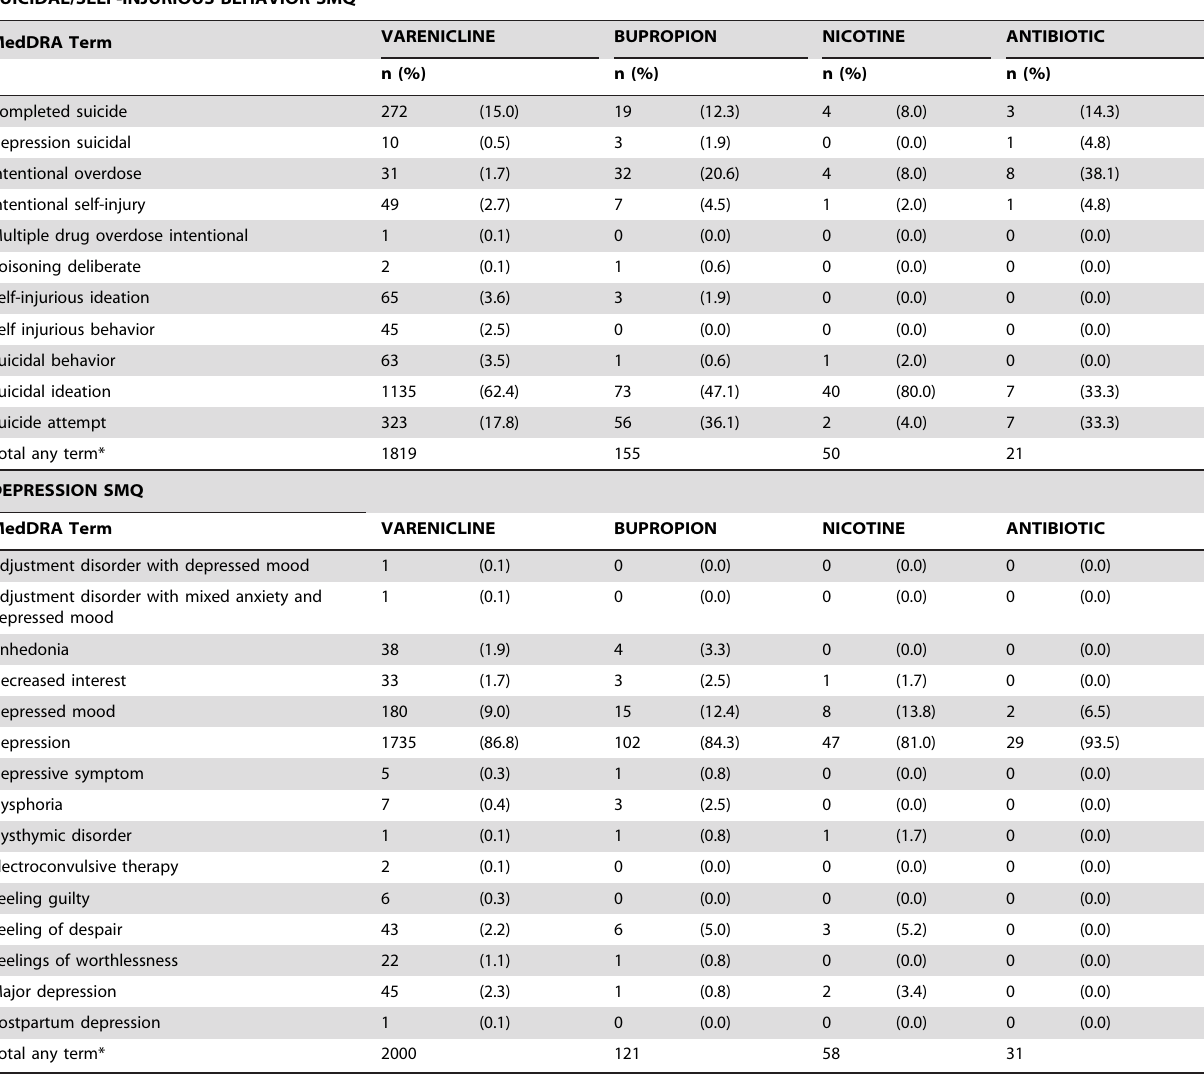
SUICIDAL/SELF-INJURIOUS BEHAVIOR